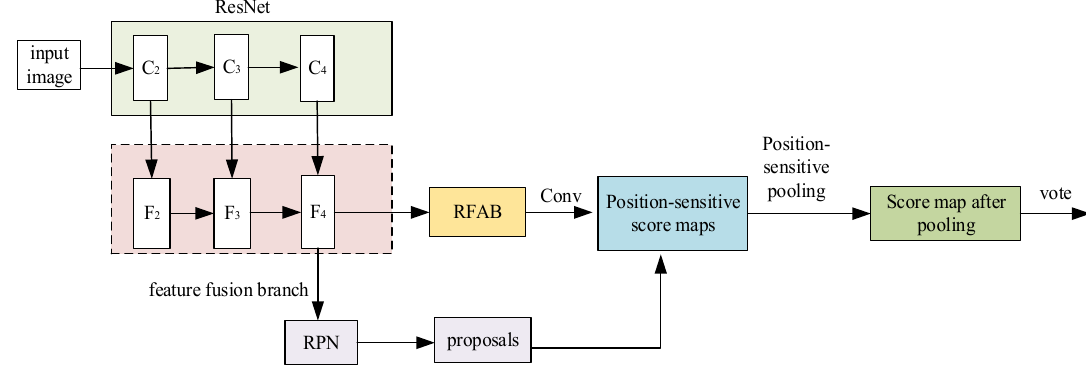
Figure 5. Structure of RFAB-f-R-FCN for small-scale face detection.